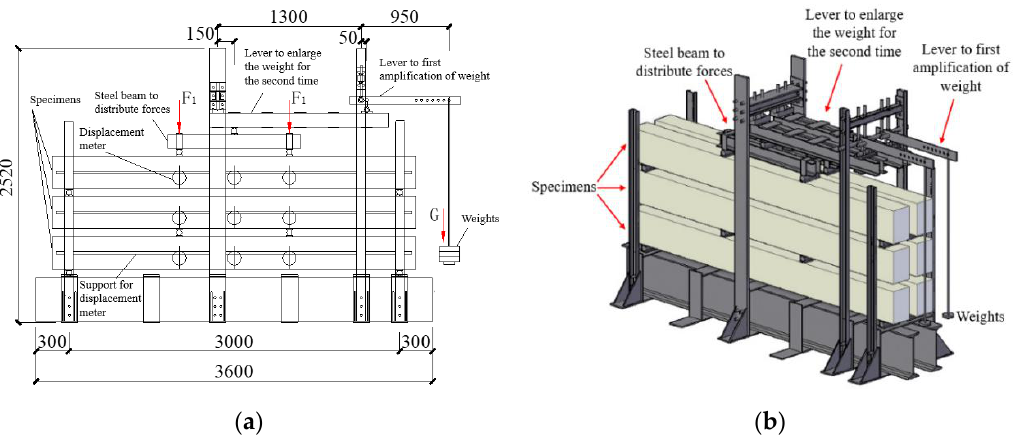
Figure 5. Schematic diagram of the loading device. ( a ) Plan of loading device; ( b ) stereogram of loading device (unit: mm).